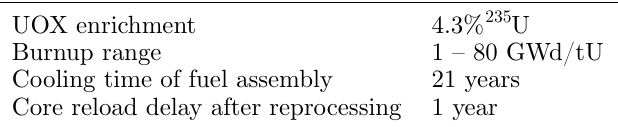
Table 1. Reference Pu vector